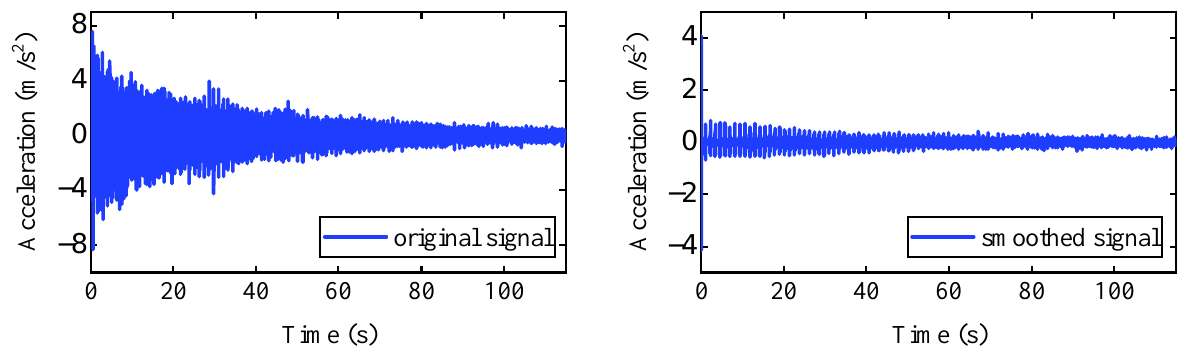
Figure 9. Condition 1 of the full-scale model experiment: original and smoothed cable vibration